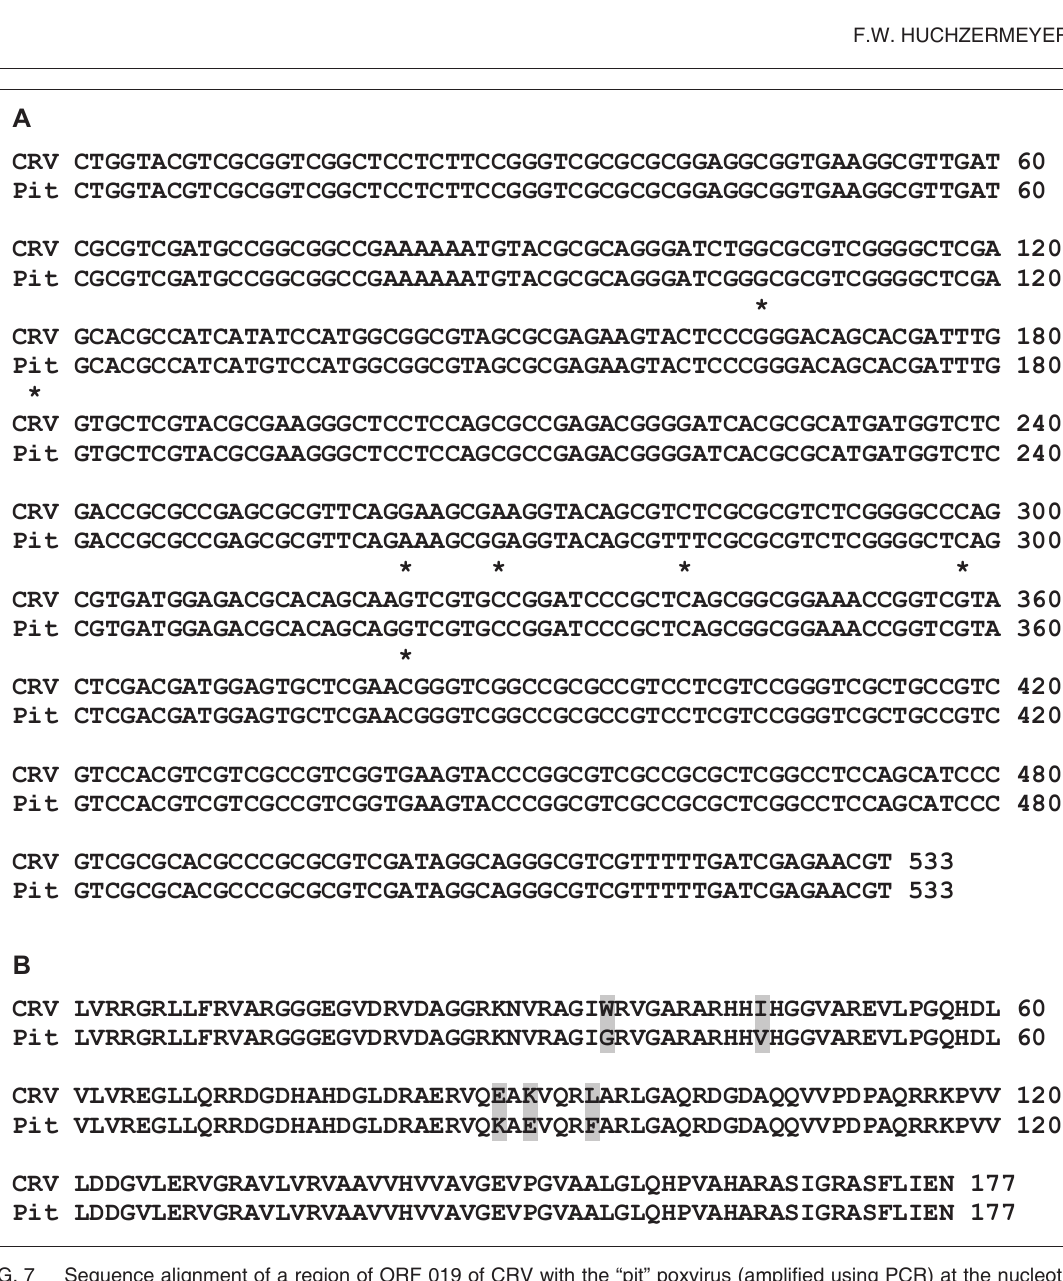
Sequence alignment of a region of ORF 019 of CRV with the “pit” poxvirus (amplified using PCR) at the nucleotide level (A) and amino acid level (B). Differences in nucleotides (*) and amino acids (grey shading) are